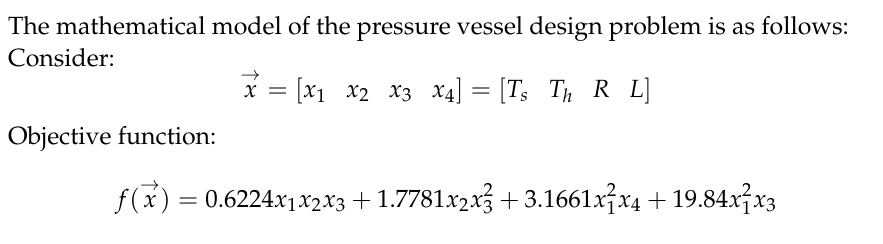
Figure 13. Model of pressure vessel design.